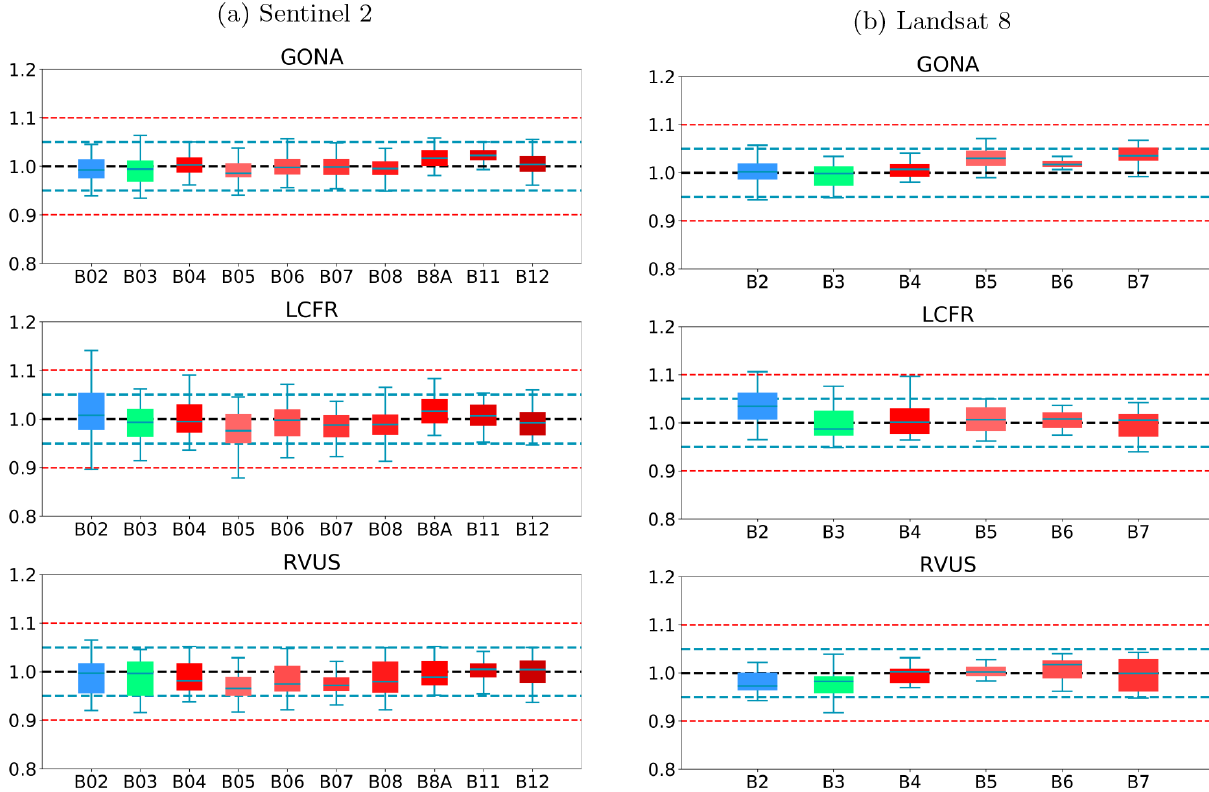
Figure 14. The ratio of SIAC-corrected S2 (a) and L8 (b) surface reflectance to RadCalNet surface reflectance over three sites. The black dashed line in the middle is the reference line of ratio 1, indicating the same values of SIAC-corrected S2 (a) and L8 (b) surface reflectance and RadCalNet surface reflectance. Values above the reference line indicate positive bias (SIAC overestimates compared to RadCalNet) and below it indicate negative bias; 5% and 10% biases are shown as dashed lines. Boxplot colours are the same as colours in Fig.